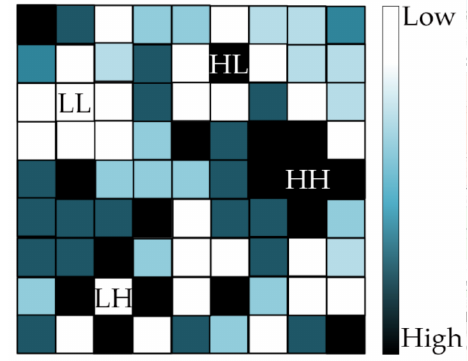
Figure 1. Four types of spatial clusters detected by local Moran’s